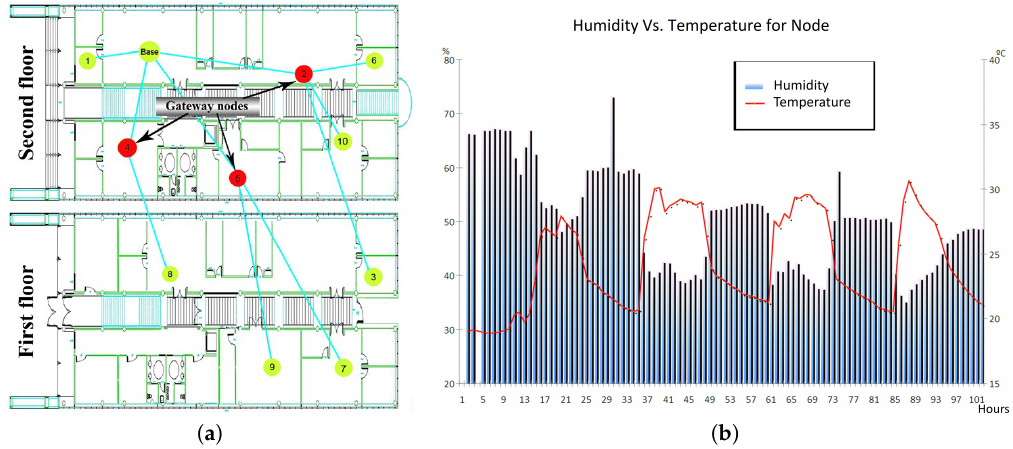
Figure 2. Experimental network of Intellbuilding Project. ( a ) Indoor network deployed; ( b ) Output example: humidity and